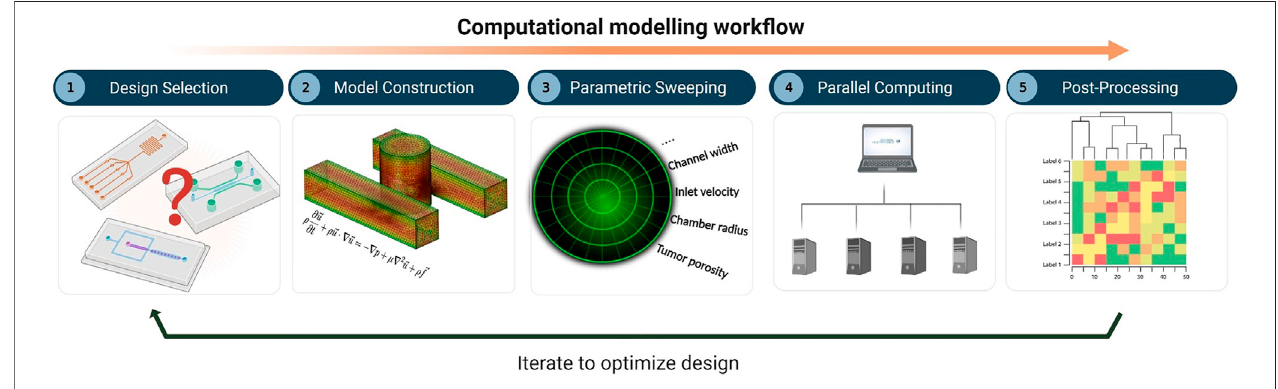
FIGURE 1 | Computational modelling work fl ow for micro fl uidic design optimization, involving: (1) design selection, (2) model construction including mesh generation, speci fi cation of governing equations, and selection of parametric levels, (3) parametric sweeping, (4) parallel computing, and (5) post-processing and